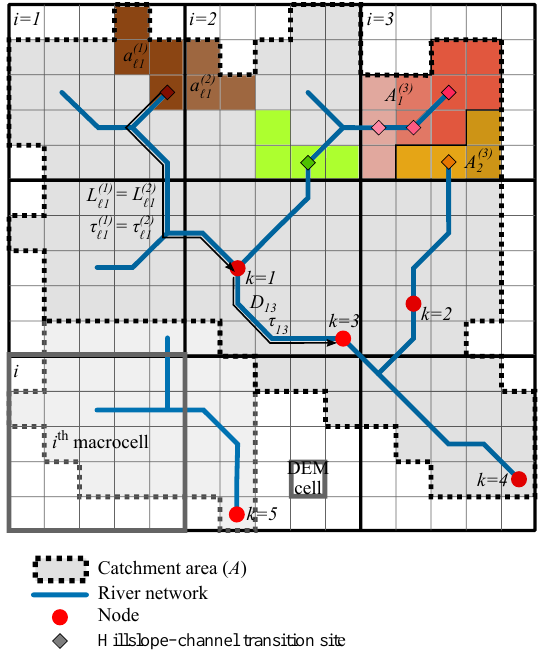
Figure 1. Sketch of basin conceptualization: subdivision of the study area into macrocells and nodes (red dots). River network is subdivided into hillslope–channel transition sites (colored squared (col- symbols) each associated with a pertaining hillslope area a (i) (cid:96)k ored areas). For this simple case we consider N = 9 macrocells and N k = 5 nodes. An example of two pathways characterized by the same length L (i) and travel time τ (i) is also (cid:96)k (cid:96)k